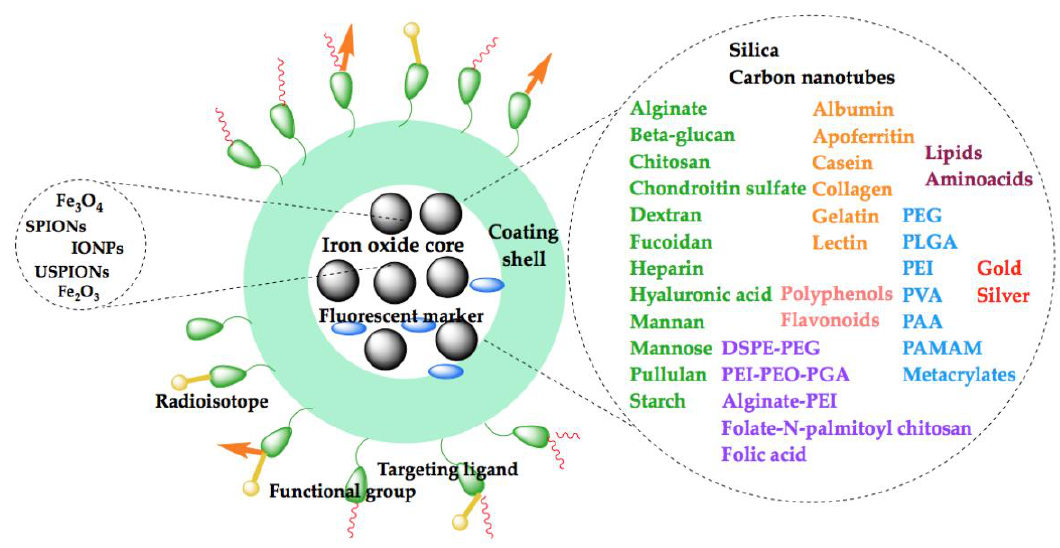
Figure 2. Schematic illustration of the coatings used for iron oxide nanoparticle functionalization for diagnostic purposes.